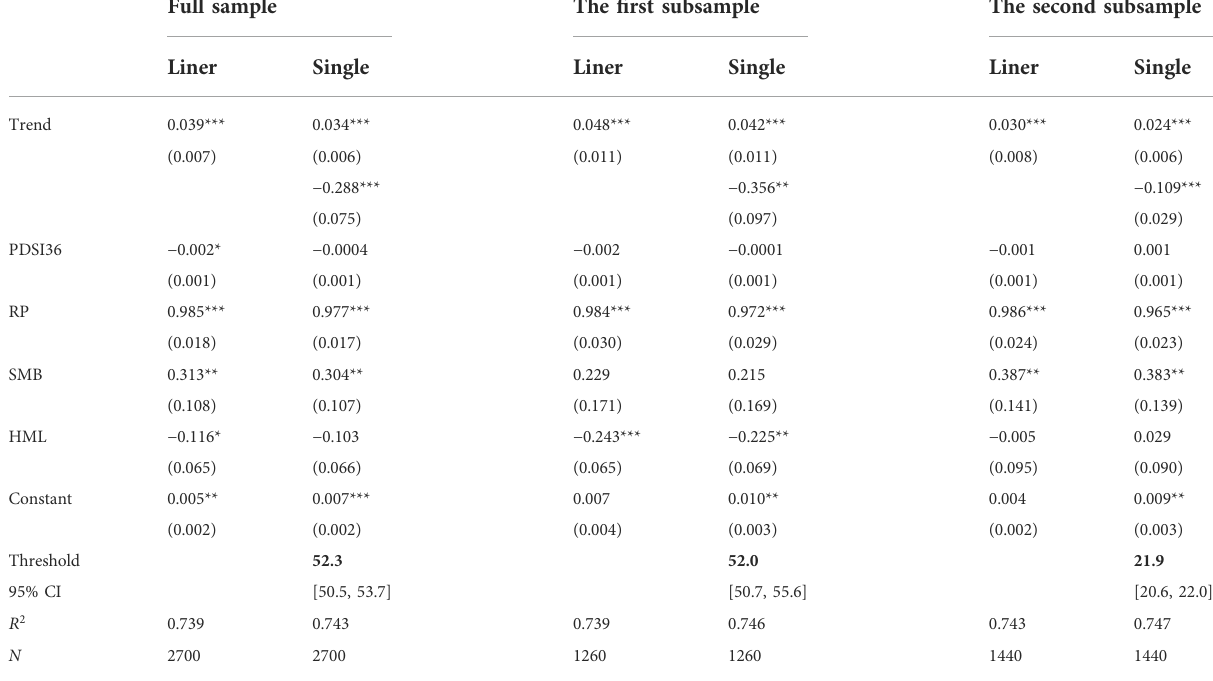
TABLE 6 Threshold regression results of investor